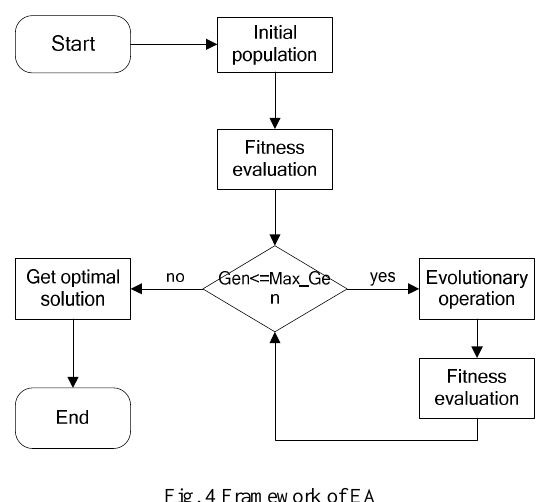
Fig. 4 Framework of